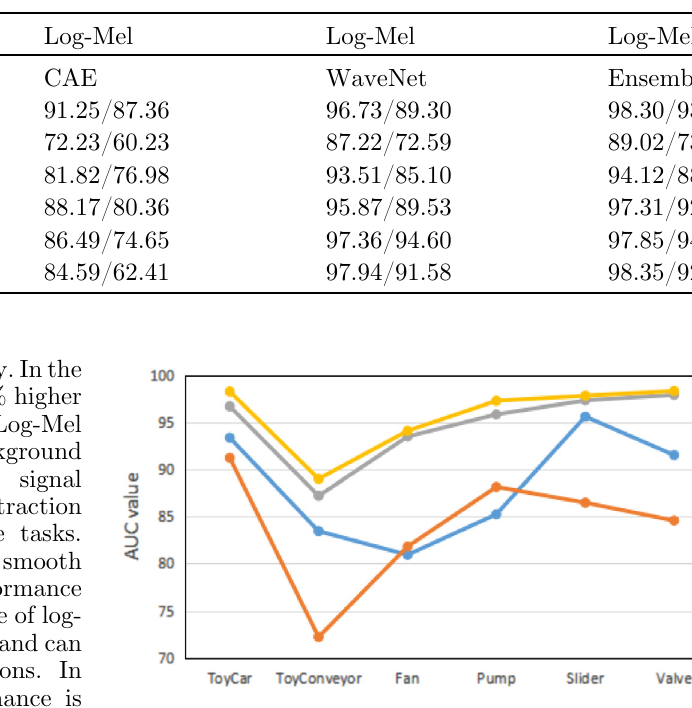
Table 5. Using the same feature extraction methods and different convolutional neural networks, AUC/pAUC value summary. All values are in %.